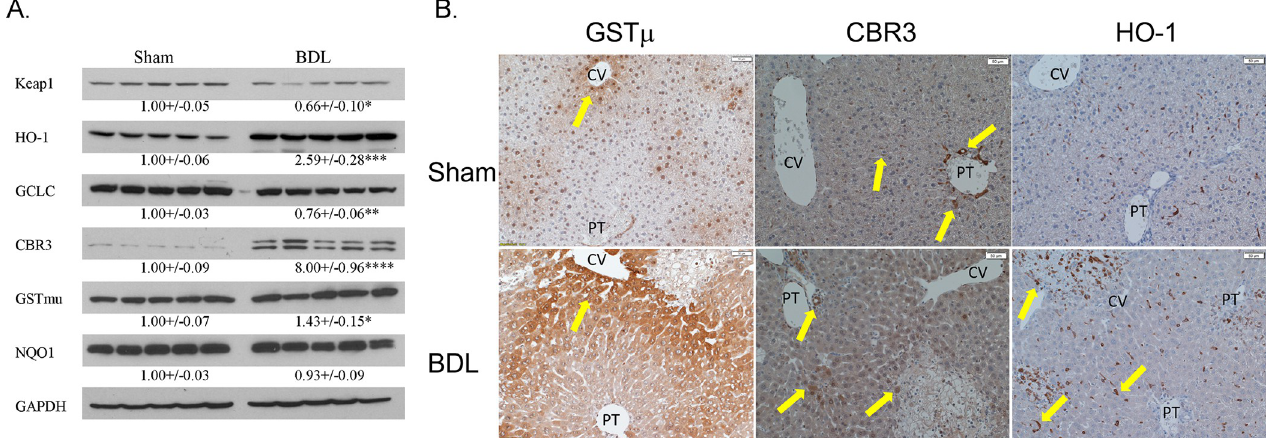
Fig 7. Increased periportal oxidative stress and upregulation of Nrf2 antioxidant proteins in acute cholestasis. A . Western analysis of selected Nrf2 target proteins (HO-1, GCLC, CBR3, GST μ , NQO1) in liver tissue isolated from sham and BDL mice. Blots were normalized to GAPDH expression. Data are presented as Mean ± SEM and were statistically analyzed using a student’s t-test, � p < 0.05, �� p < 0.01, ��� P < 0.001, ���� p < 0.0001, N = 5/group. B . Tissue sections from sham and BDL mice were probed immunohistochemically for GST μ , Cbr3 and HO-1. N = 4/group, 200X, PT-portal triad, CV-Central vein. Arrows indicate area of increased